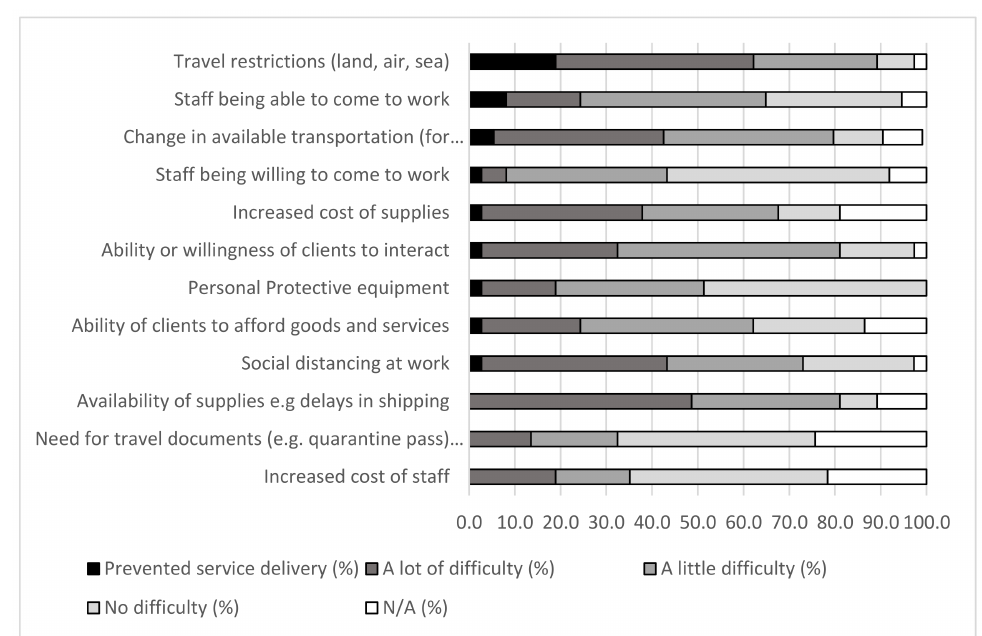
Figure 5. COVID-19 related impacts on assistive technology providers.